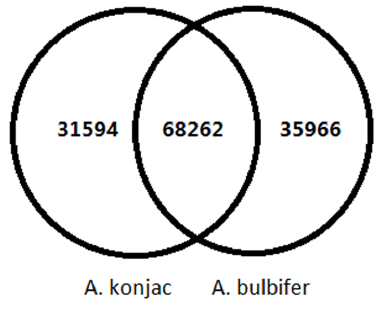
Figure 2. Comparison of the unigenes from A.konjac and A. bulbifer